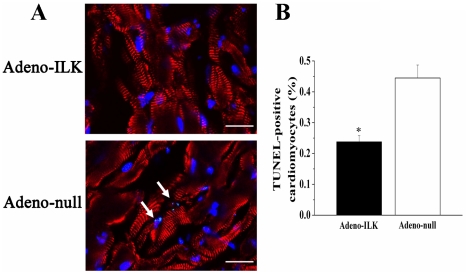
Cardiac ILK gene therapy protects left ventricular cardiomyocytes from apoptosis in doxorubicin-induced heart failure.A, Triple-staining with TUNEL (green, arrows), anti-α-sarcomeric actin antibody (red) and DAPI (blue) in left ventricle. B, Quantification of TUNEL-positive cardiomyocytes in left ventricle from adeno-ILK and adeno-null treated rats. n = 6 per group. *P<0.05 versus adeno-null group. Scale bars: 20 µm.